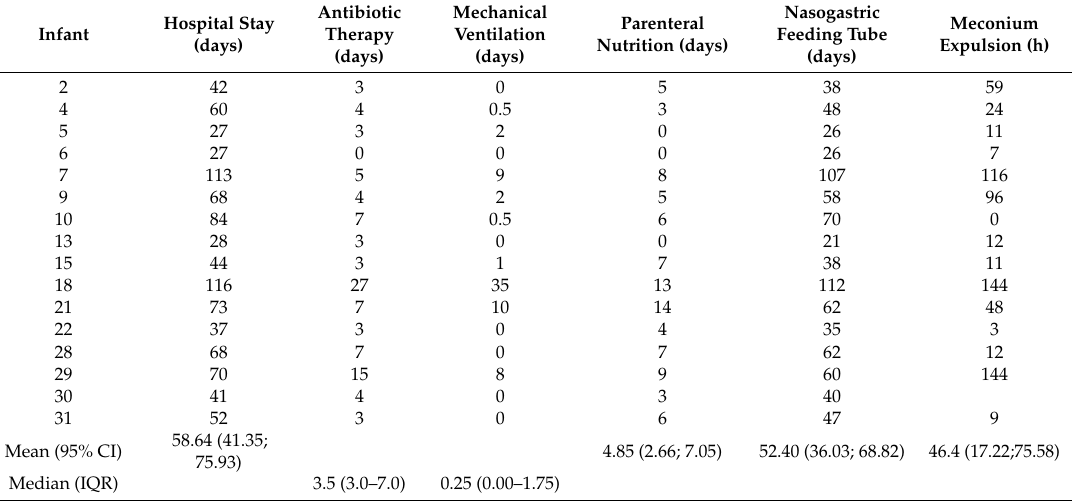
Table 2. Clinical characteristics of the preterm infants recruited in this study.